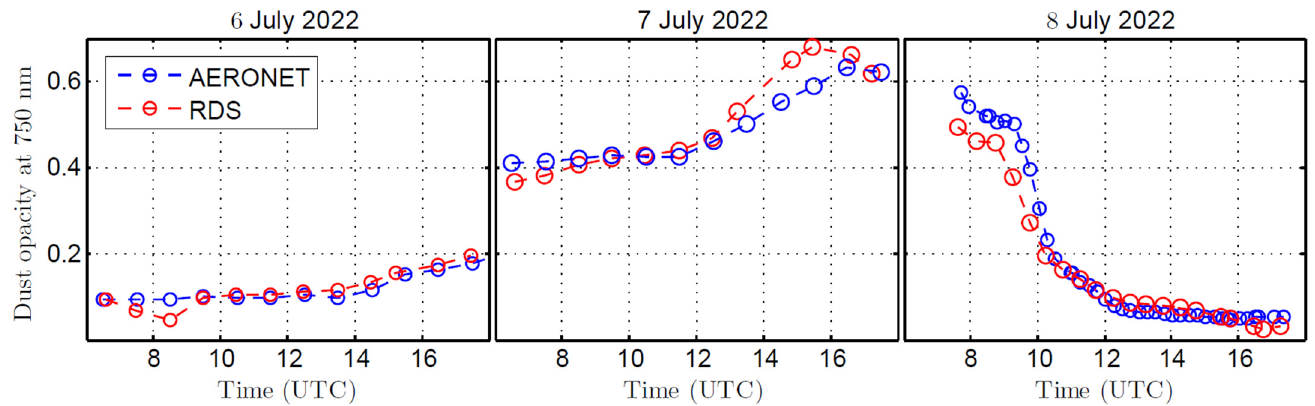
Figure 26. Aerosol optical depth derived from RDS observations and AERONET at 750 nm for the 3-day campaign period .